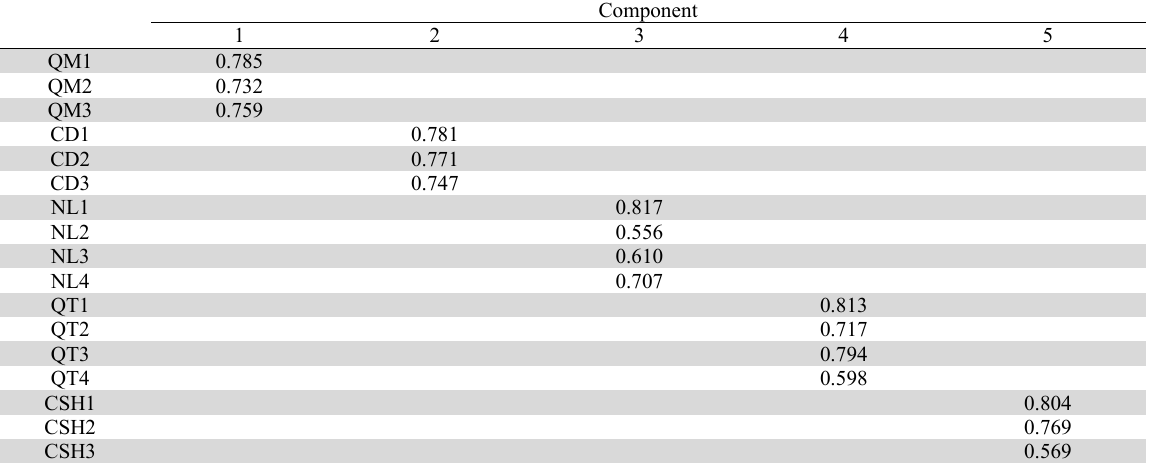
The factor transformation matrix of independent